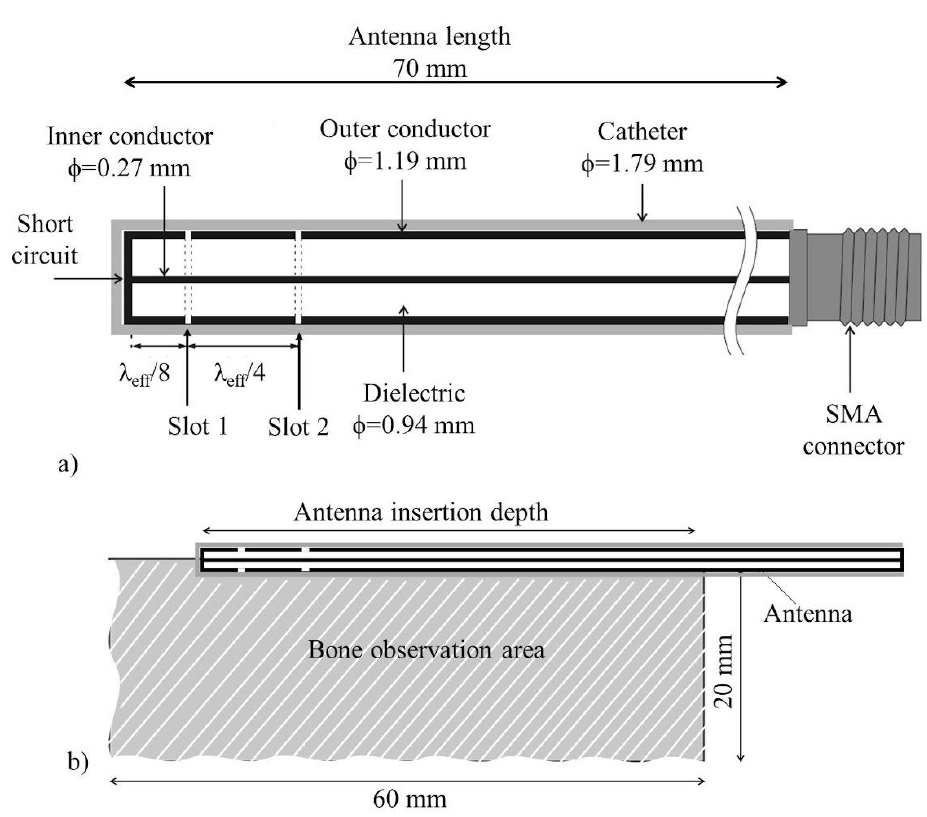
Figure 1. Geometry description of the proposed antenna, ( a ) 2D view of the proposed double slot antenna, ( b ) 2D axisymmetric model used to determine the outcome when bone tissue (observation area) is